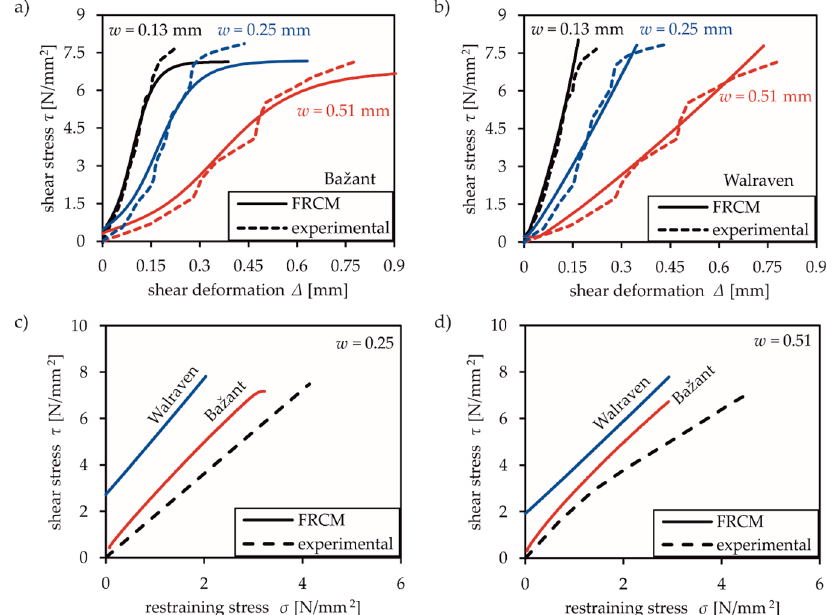
Figure 12. Comparison of numerical results with FRCM (aggregate interlock models by Walraven and Bažant) and experimental results, ( a ) shear stress-deformation for Bažant, ( b ) shear stress-deformation for Walraven, ( c ) and ( d ) relation of shear stress and restraining stress.